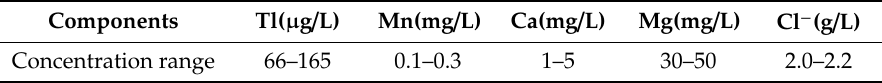
Table 1. Concentration range of main elements in the industrial